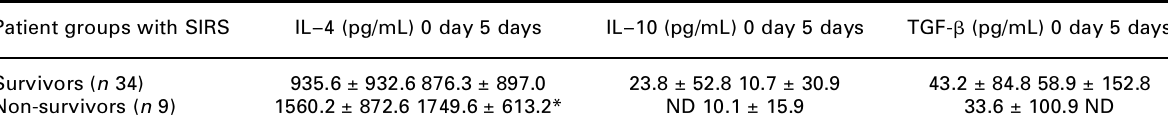
Table 2. Serum levels of IL–4, IL–10 and TGF- b in survived or not-survived patients with SIRS at the time of diagnosis and five days later Patient groups with